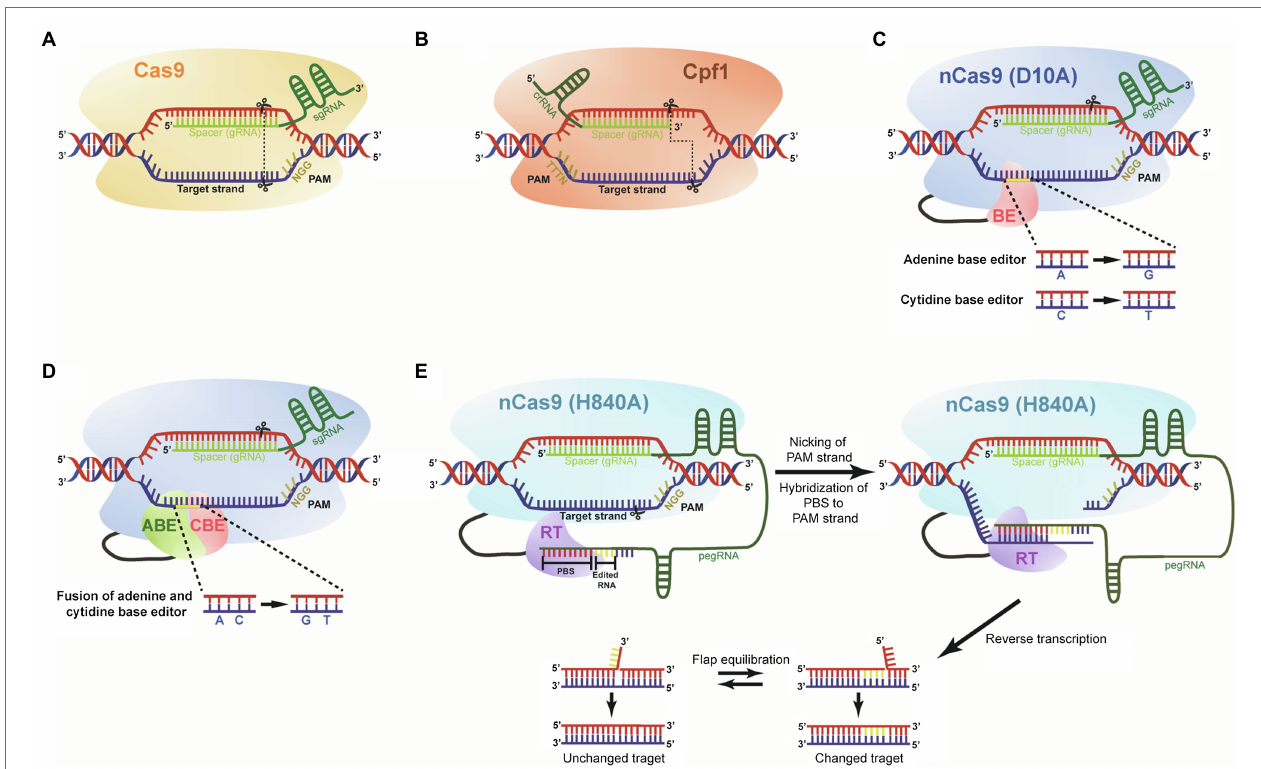
FIGURE 2 | The main CRISPR-Cas-mediated genome-editing systems. (A) Diagram of the CRISPR-Cas9 is shown with a sgRNA encoding a spacer guide RNA (gRNA) positioned next to PAM (5 ' -NGG) site. Cleavage sites by Cas9 protein are shown with scissors, and blunt ends are presented with dotted line. (B) A diagram of the CRISPR-Cpf1 is shown with crRNA encoding a spacer gRNA positioned next to PAM (5 ' -TTTTN) site. Cleavage sites by Cpf1 protein are shown with scissors, and staggered ends with 5 ' overhang are presented with dotted line. (C) Base editor (BE) composed of nCas9 nickase (D10A). The base editing system has two versions: adenine and cytidine BEs converting A to G and C to T, respectively. (D) nCas9 nickase (D10A) fused with adenine base editor and cytidine base editor generates A to G and C to T substitutions, simultaneously. (E) Prime editor composed of nCa9 nickase (H840A), reverse transcriptase (RT), and prime editing guide RNA (pegRNA). The pegRNA carries spacer, desired editing sequence, and primer binding site (PBS). The PBS binds to the nicked strand, and then, RT copies sequences from the template. Flap equilibration results in unchanged and mutated DNA